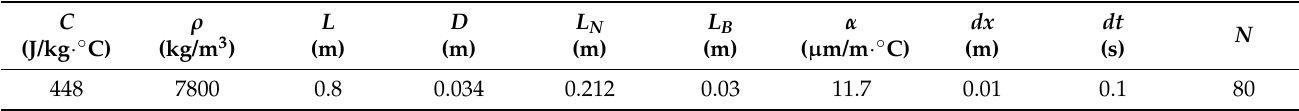
Table 1. Parameters determined from the screw and machine